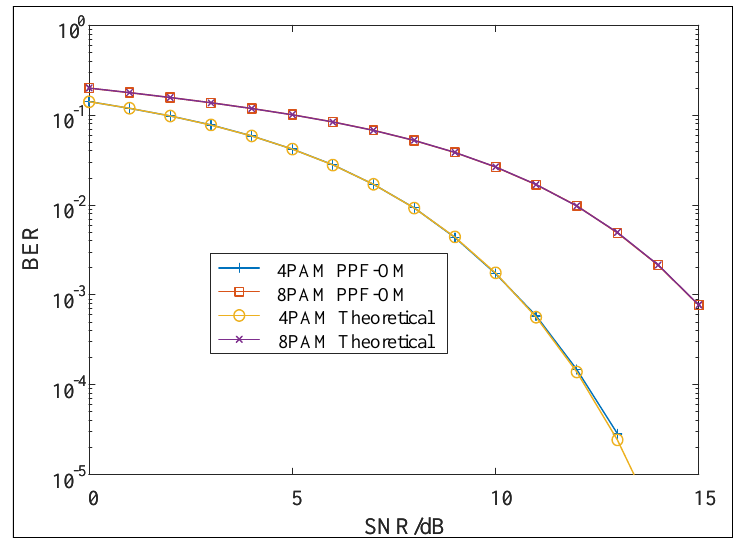
Figure 4. BER performance of PPF-OM (PAM).